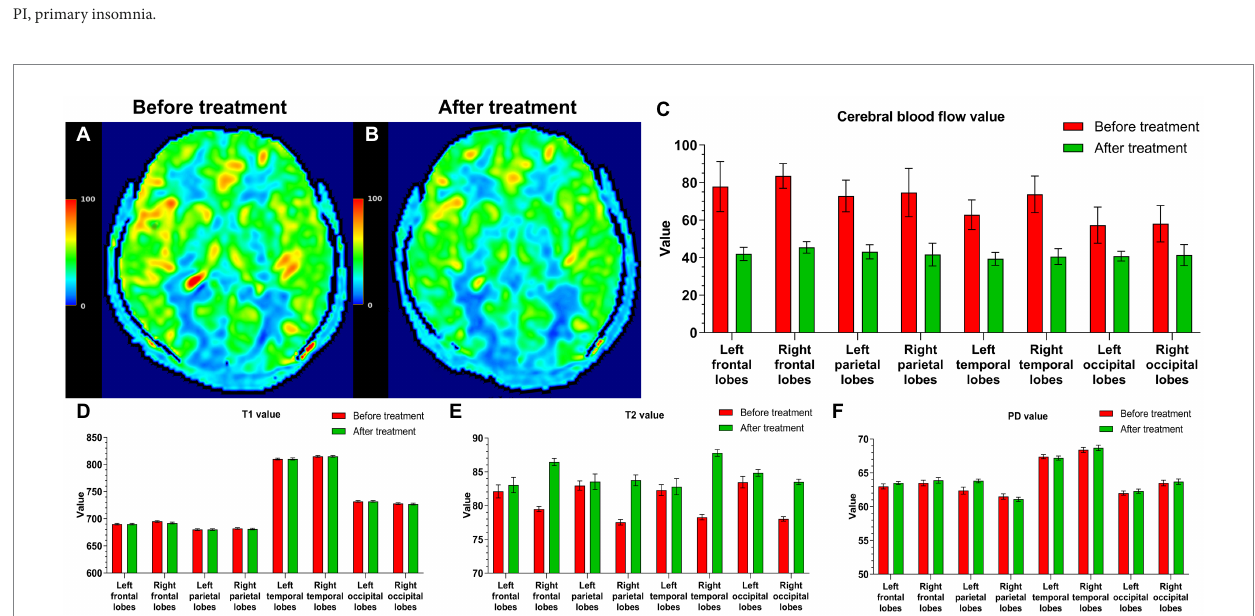
FIGURE 6 Five PI patients were reexamined 6 months after treatment. Cranial MRI showed that in a CBF pseudocolor image, the signal in the high-intensity area (A) of the initial diagnosis was reduced (B) . The CBF values after treatment were also lower than those before treatment (C) . The T2 values of all five patients were higher than those before treatment (E) , and the T1 and PD values did not change after and before treatment (D,F)